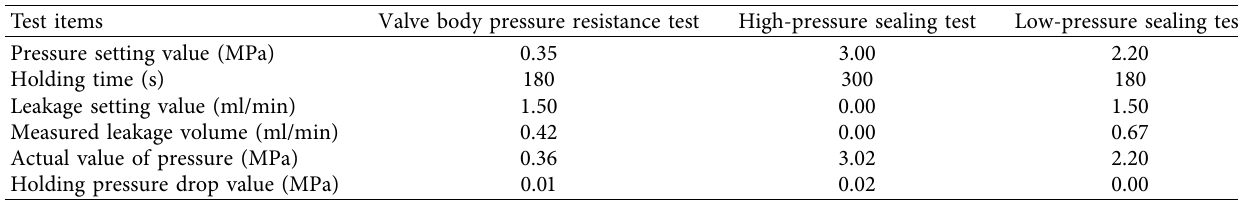
Table 3: Test results.